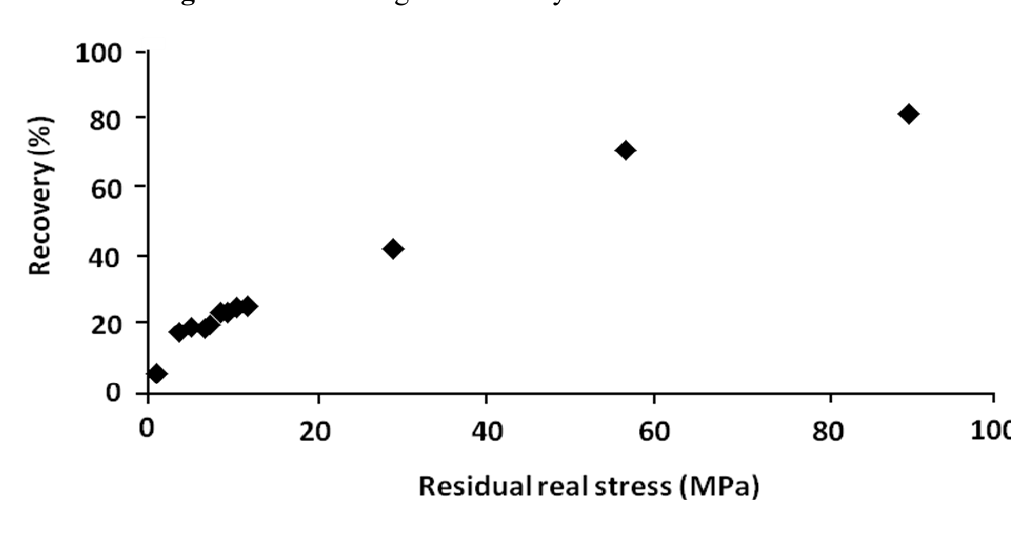
Figure 12. Percentage of recovery versus residual real